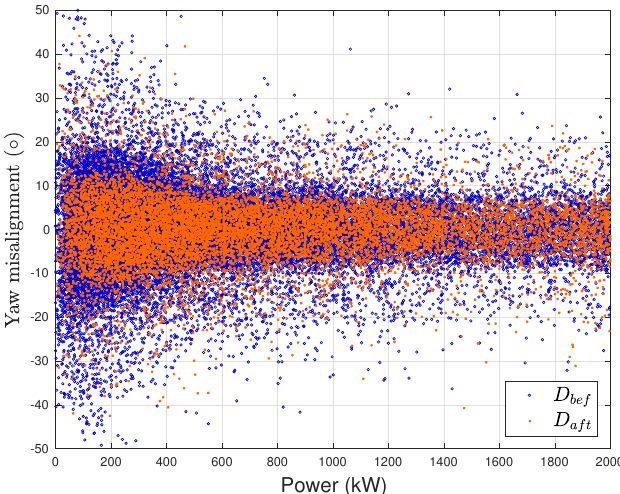
Figure 3. The T1 yaw misalignment during D bef and D aft .